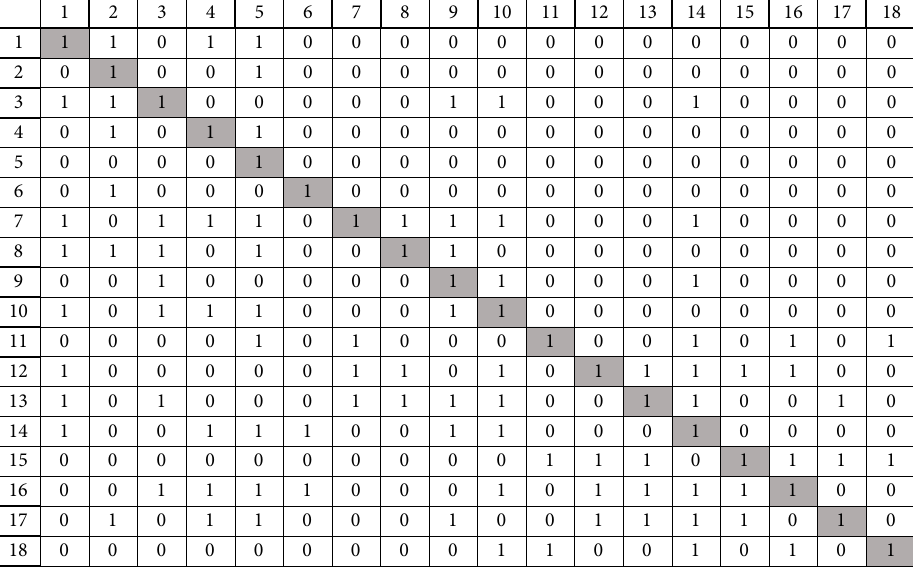
Table 4. A structural self-interaction matrix for ISM construction